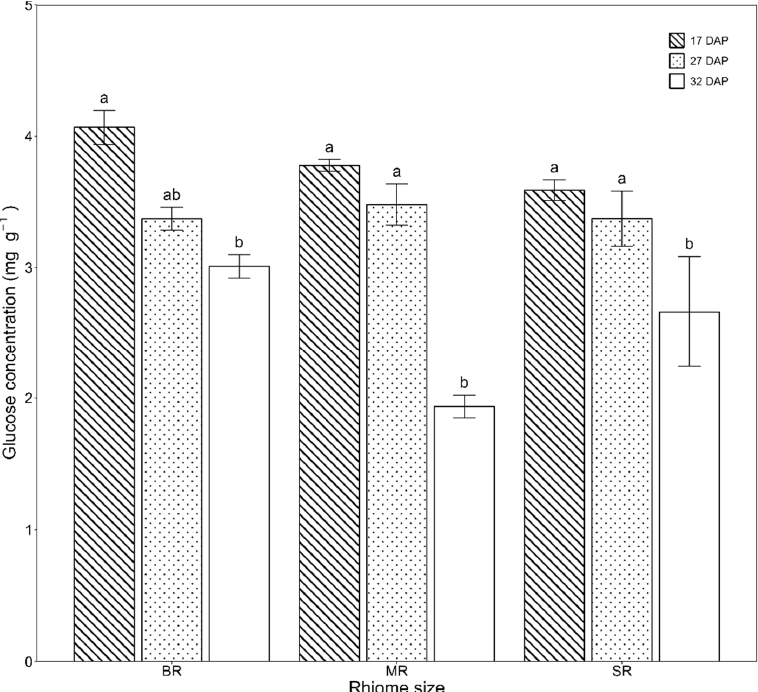
Figure 4. The glucose concentration in rhizomes on 17, 27 and 32 DAP in EXP.1. Note: BR, MR and SR refer to big, medium and small rhizome weight in EXP.1, respectively. The different lower-case letters indicate significant probability difference at p < 0.05 among sampling dates. The error bars represent standard errors ( n = 3).